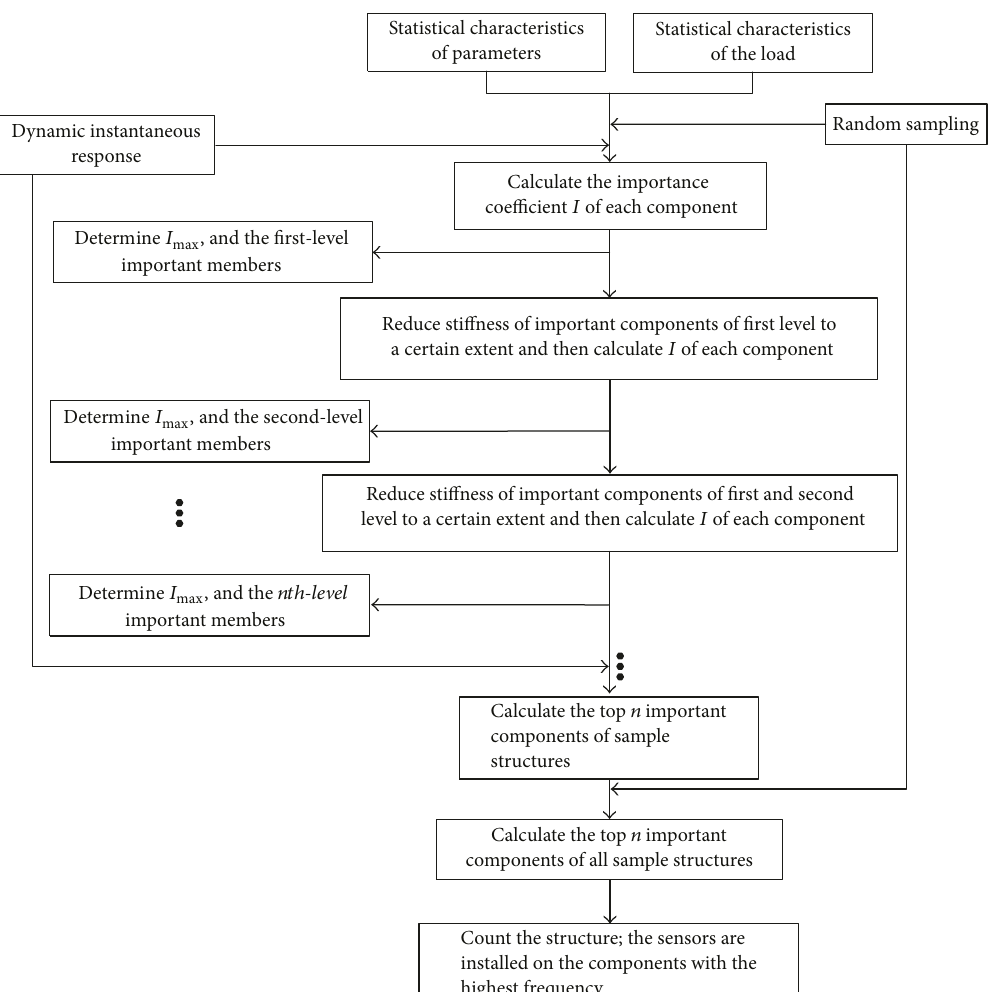
Figure 4: Flow chart of sensor placement considering dynamic load.